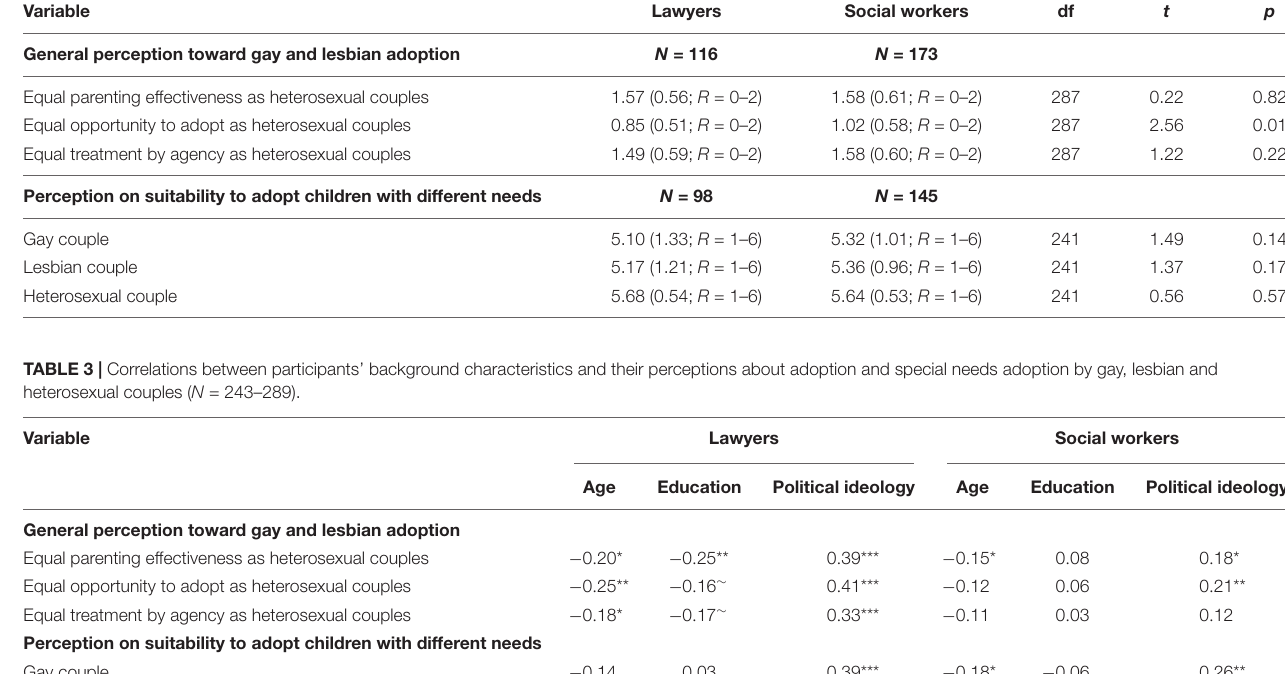
TABLE 2 | Summary of t -tests comparing means (SDs) of lawyers and social workers’ perceptions toward adoption by gay couples and lesbian couples and perception on their suitability to adopt children with special needs. Variable